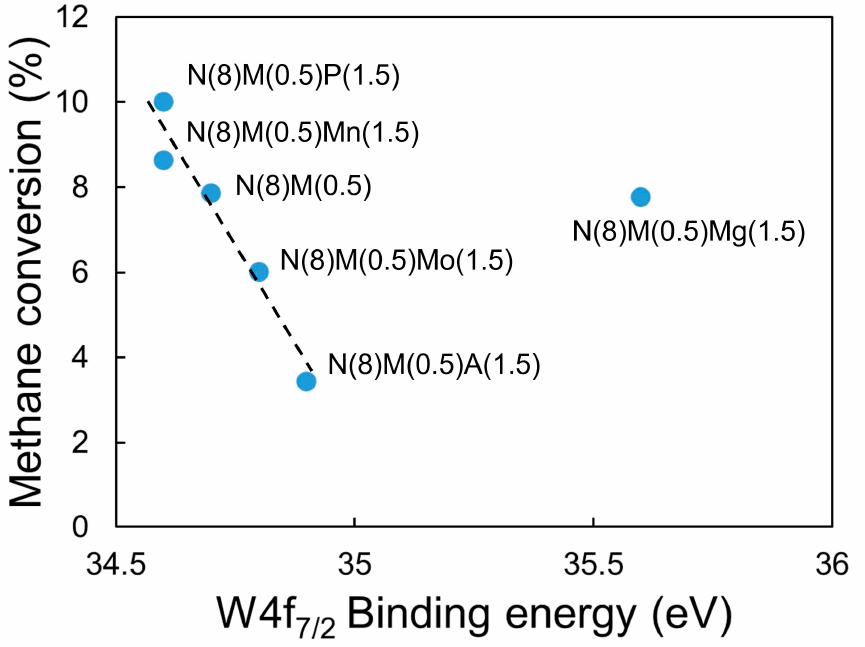
Figure 6. Correlation between W f4 7/2 binding energy of spent catalyst and methane conversion.